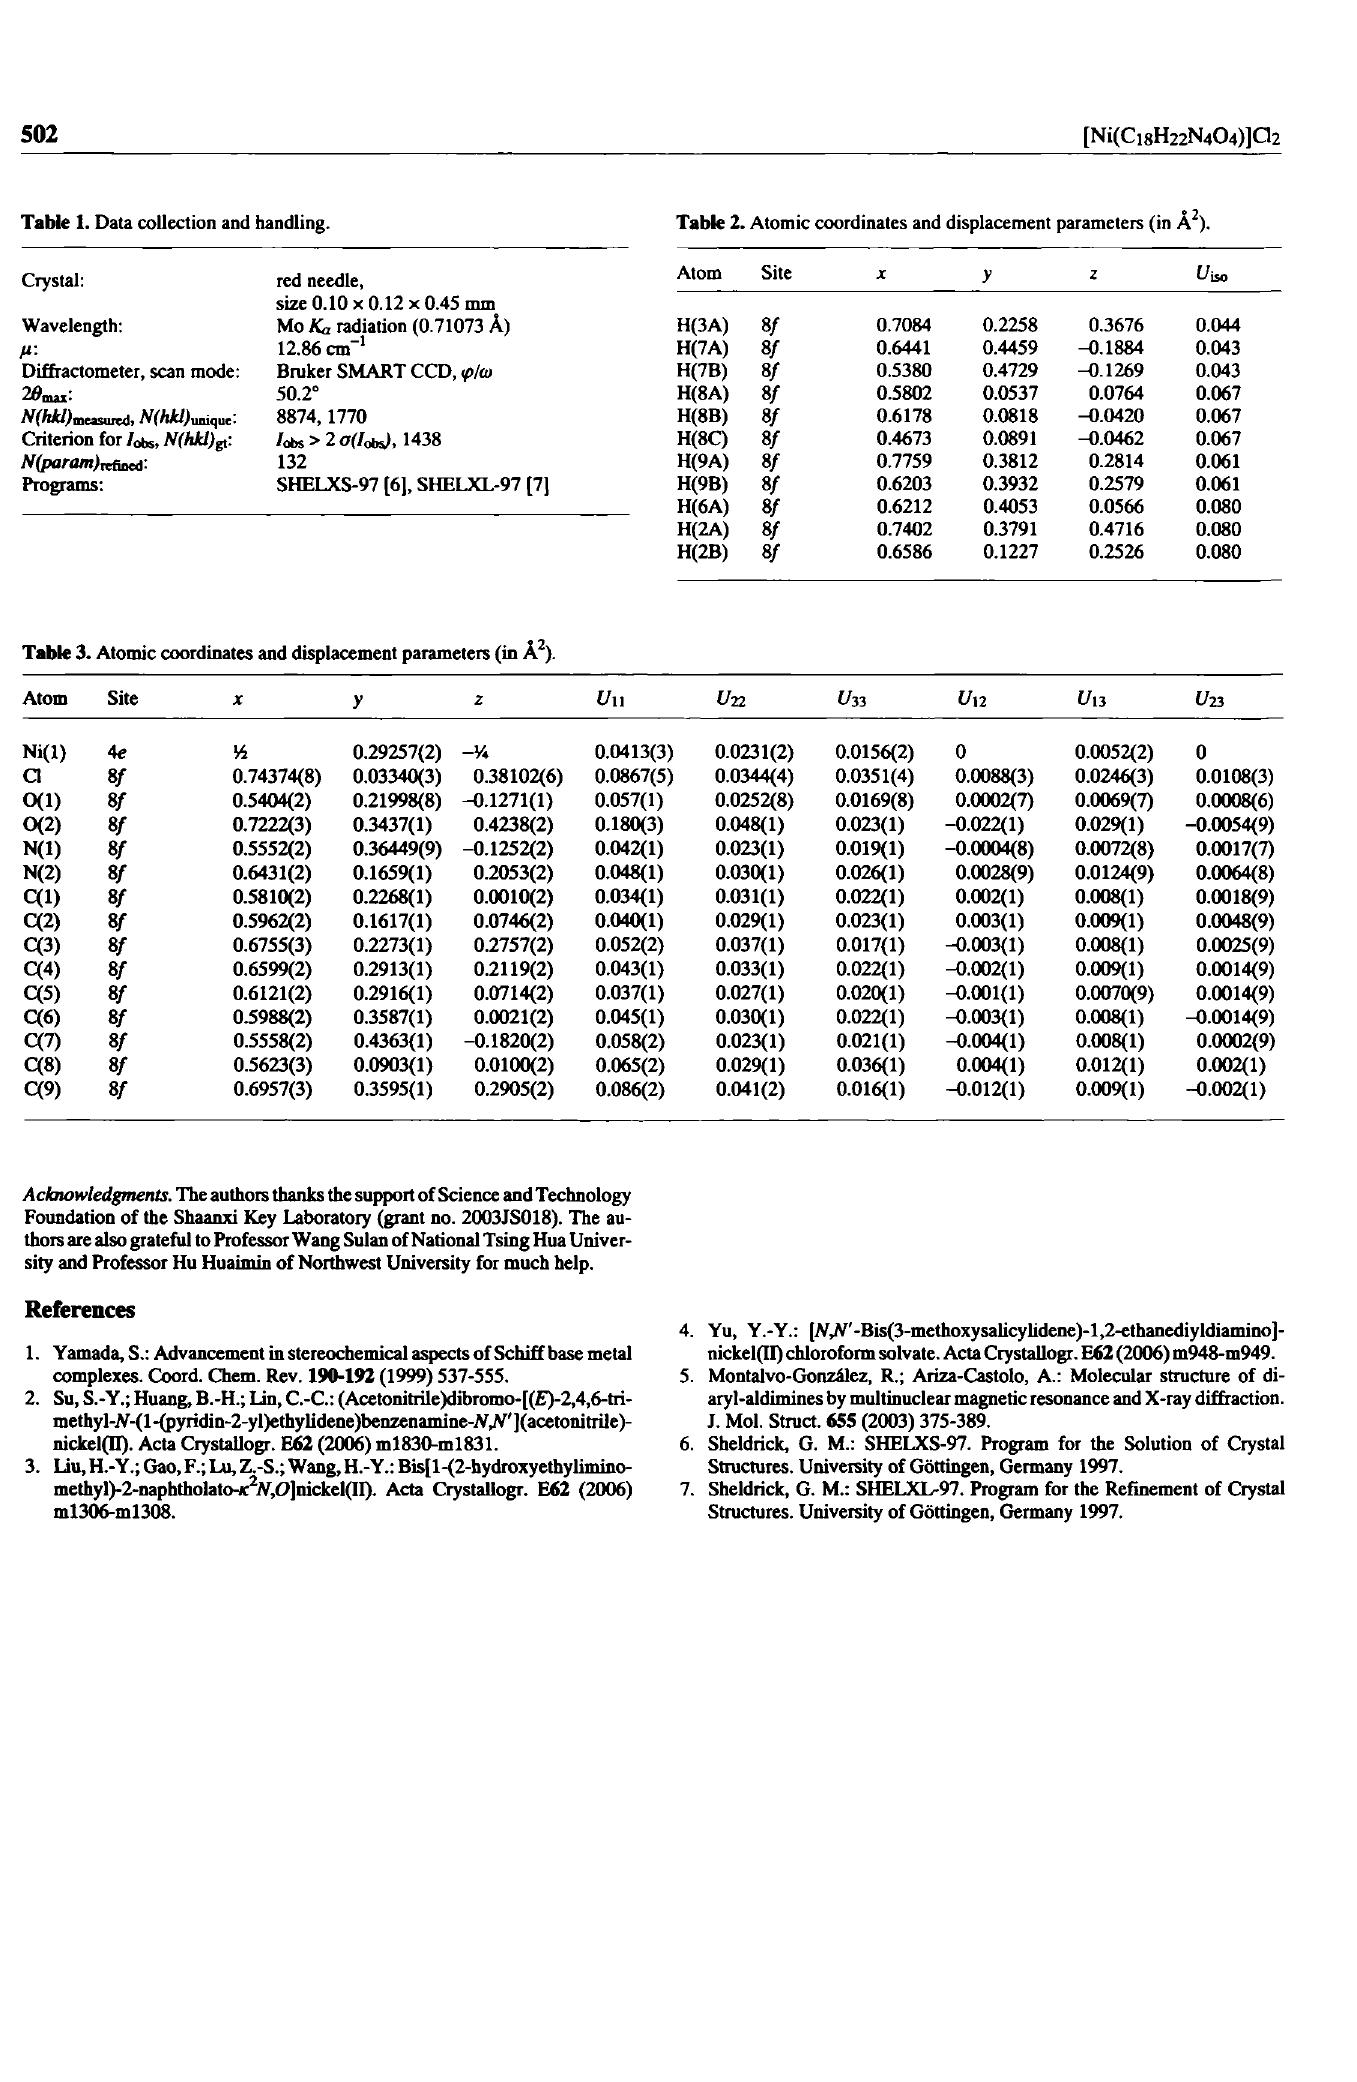
Table 3. Atomic coordinates and displacement parameters (in A 2